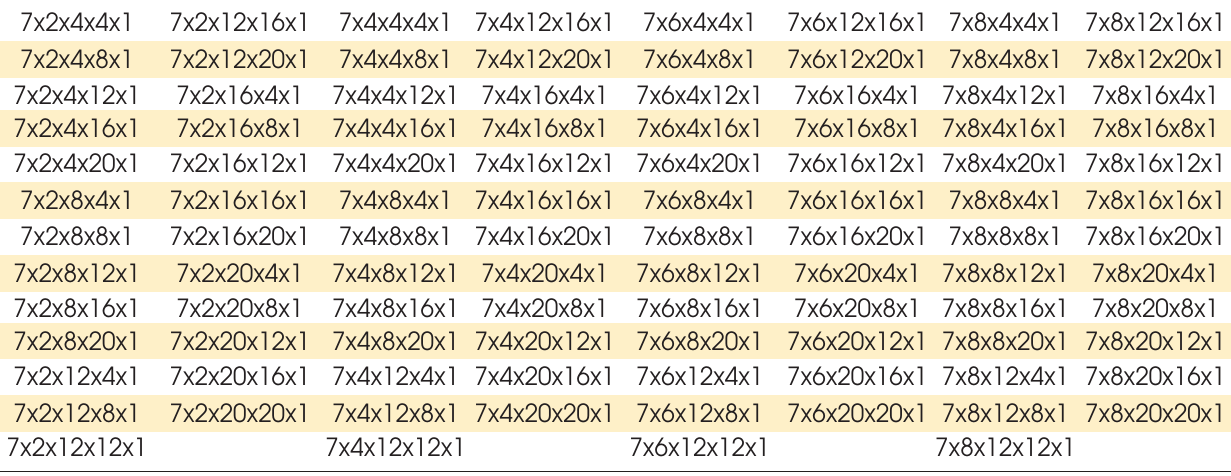
Table 1 – Summary of the configurations of the